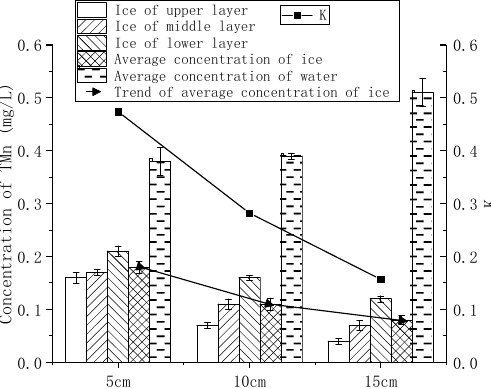
Figure 4. Distribution of TMn in the Ice-water System. Under Different Conditions of Ice Thickness.